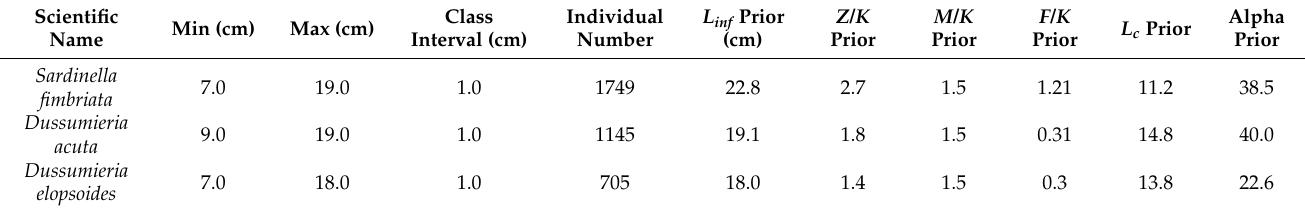
Table 1. Prior and basic information of three sardine populations in BoB,